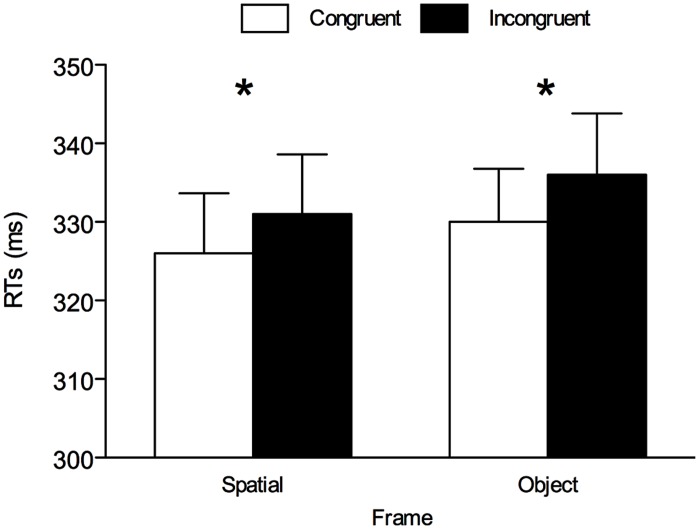
Mean reaction times (RTs) for all conditions in Experiment 1. Asterisks denote p < 0.05. Error bars are SEM.